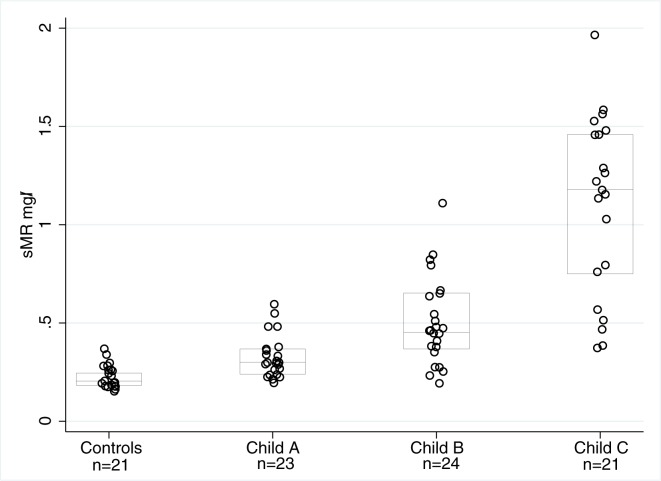
sMR in cirrhosis.sMR (mg/L) levels in healthy control subjects and patients with different degrees of liver cirrhosis. P < 0.05 controls compared to patients with liver cirrhosis. P < 0.05 CP-C compared to CP-A and CP-B.